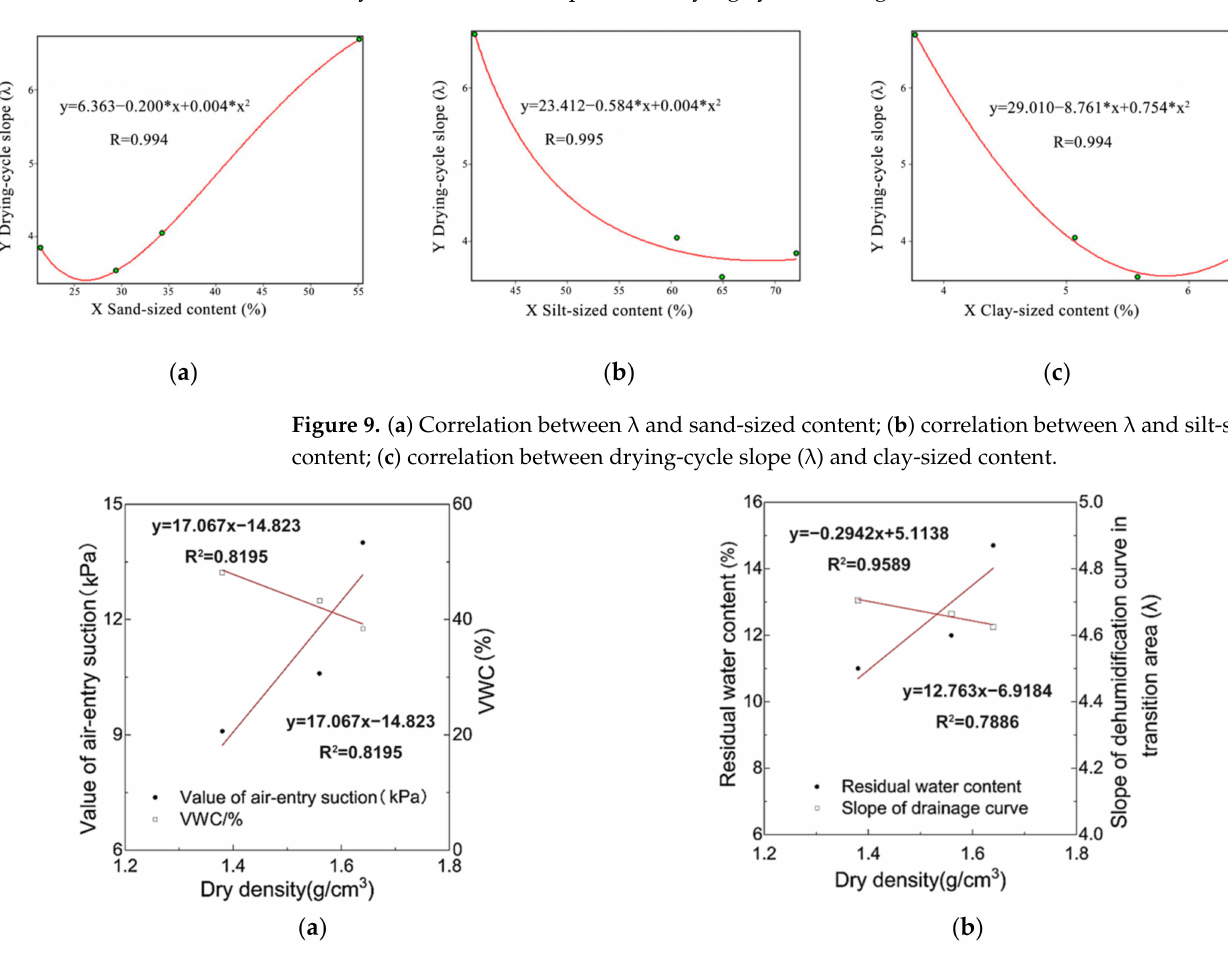
Figure 10. Correlation between SWCC parameters and dry density. ( a ) Relationship between value of air-entry suction, VWC and dry density. ( b ) Relationship between residual water content, λ and dry